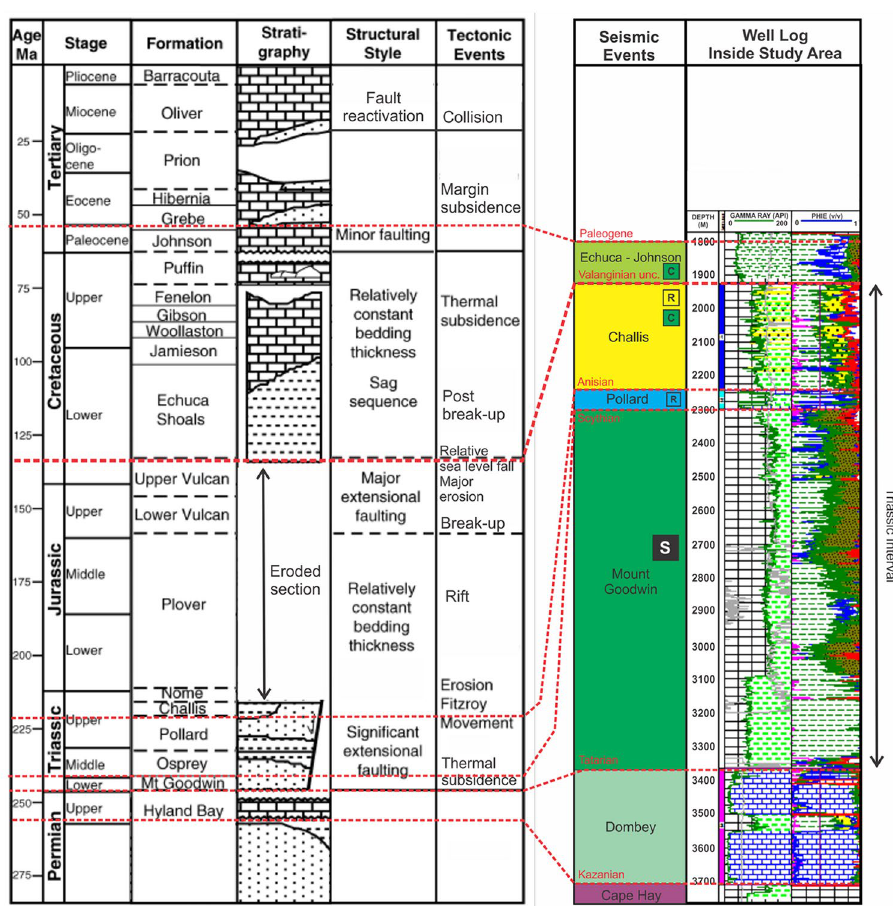
Fig. 2 Regional stratigraphy, structural style and main tectonic events of the study area (Keep et al. 2002; Longley et al. 2002; Cadman and Temple 2003; Chen et al. 2012 with modification) calibrated with seismic marker and well log